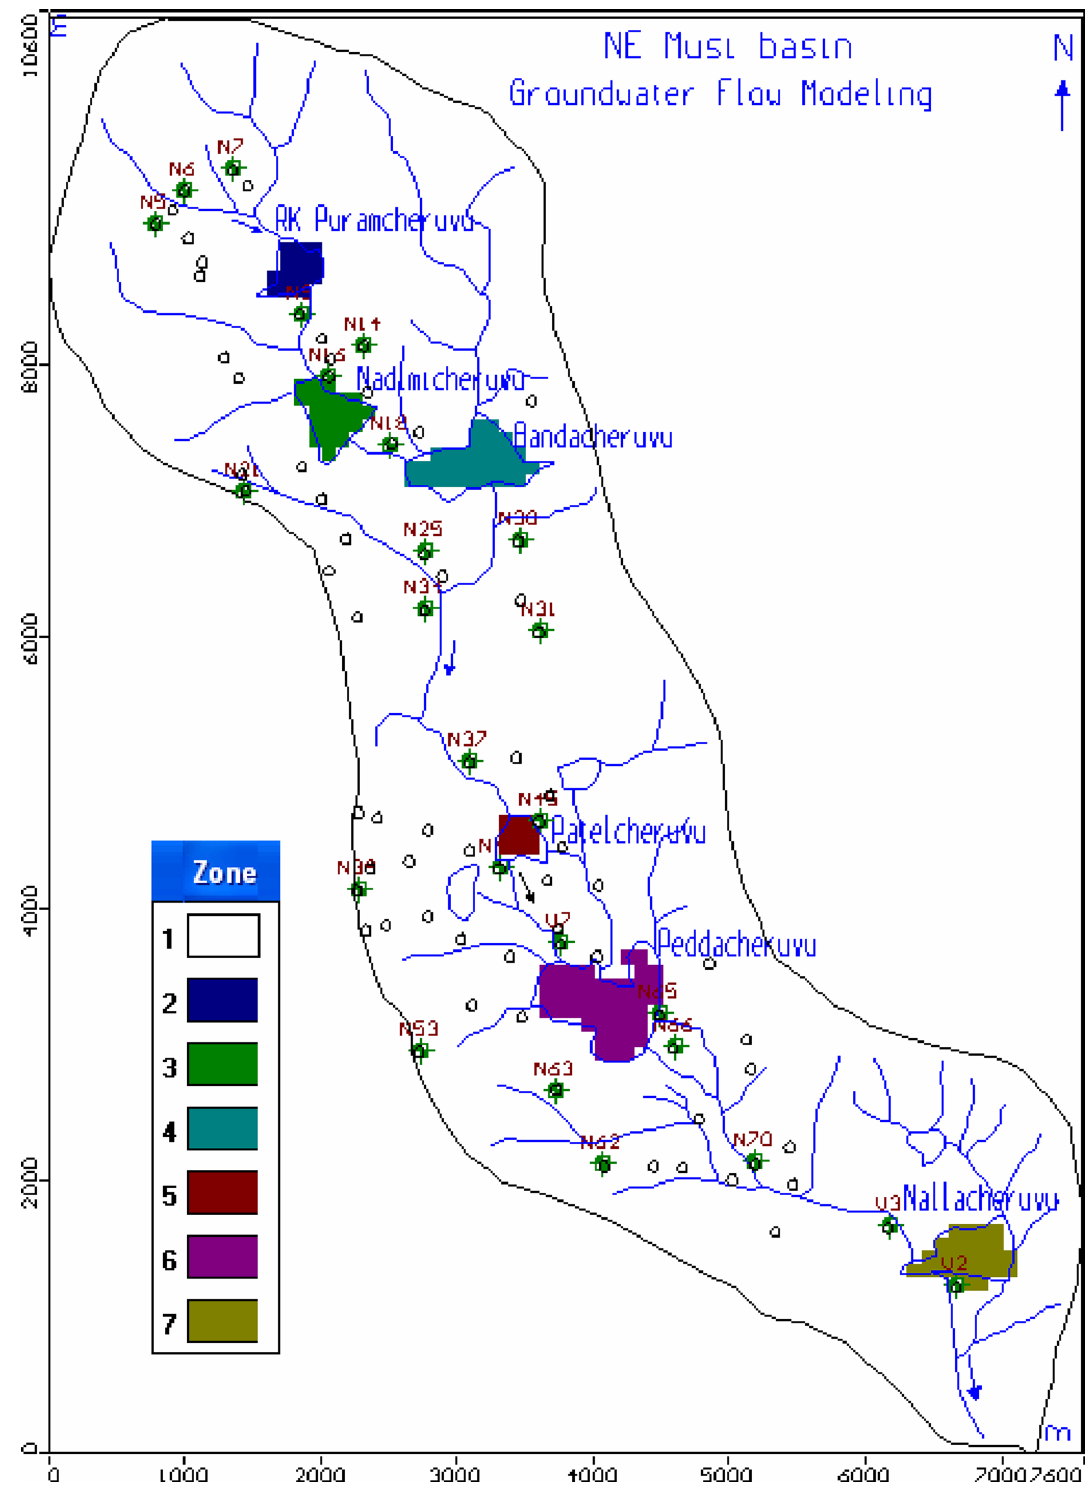
Fig. 9 Zones for groundwater budget of